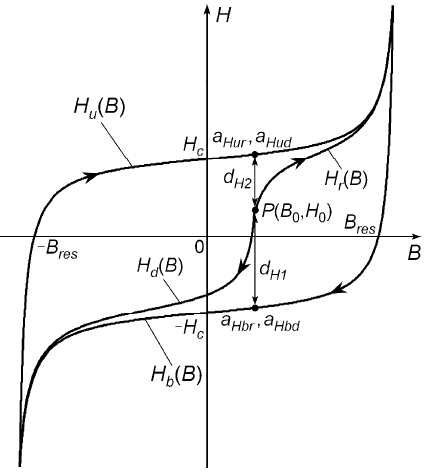
Figure 4. Inverse hysteresis loop; d H 1 = H 0 − H b ( B 0 ), and d H 2 = H u ( B 0 ) − H 0 . Similar to the previous equations, the coefficients k Hr and k Hd are first dependent on the position of point P ( B 0 , H 0 ). The derivative d H r /d B is in the range ( a Hur , a Hbr ) for increasing values of B . The parameter a Hur is equal to the value of the derivative d H u ( B 0 )/d B when the initial point P ( B 0 , H 0 ) is located on the upper limiting curve H u ( B ), and the parameter a Hbr is equal to the derivative d H r ( B 0 )/d B when the point P ( B 0 , H 0 ) is sufficiently close to the bottom curve H b ( B ). Similar to the previous derivations, the value of a Hbr is determined based on measurements of several symmetric hysteresis loops.